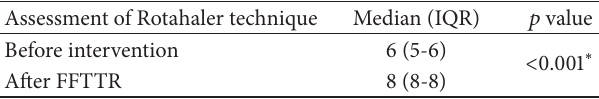
Table 2: Effect of FFTTR on correct use of Rotahaler technique ( 𝑛 = 20